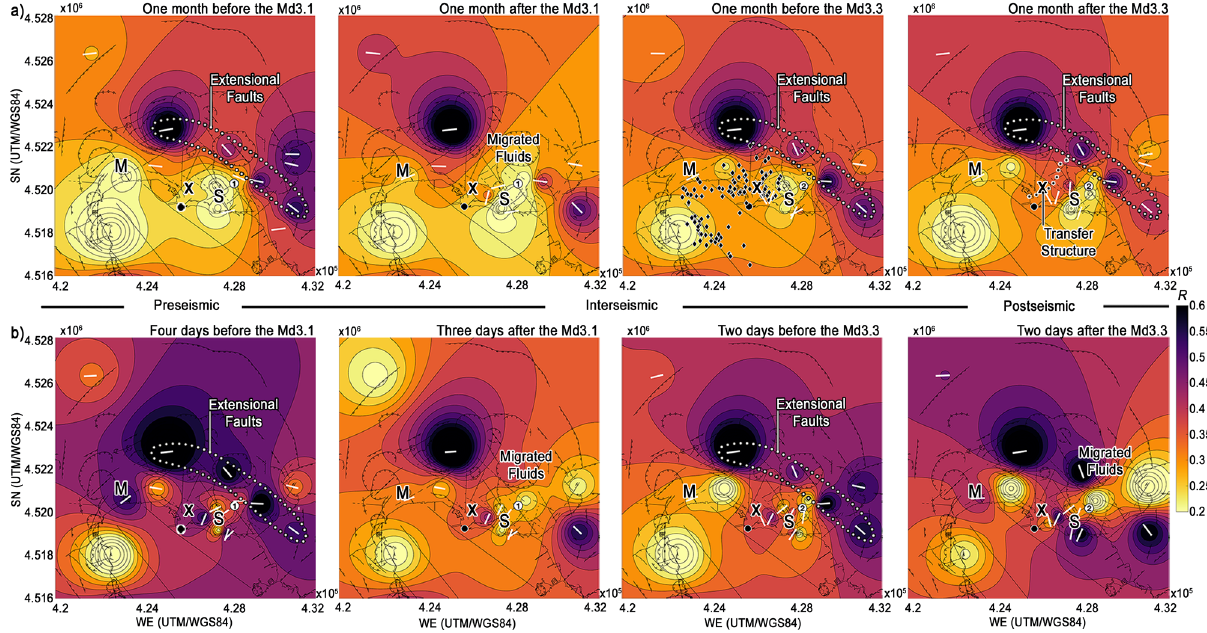
Fig. 3 Build-up and release of fl uid-induced stress. a The polarization parameters have been plotted using data spread across one month before and after both the Md3.1 and the Md3.3 earthquakes. Black diamonds correspond to the earthquake locations between June and December 1984 16 . The white dotted line contours the extensional faults when visible and continuous. Migrated fl uids break this continuity. b The olarization parameters were computed using three hours of noise on a single day, before and after the Md3.1 and